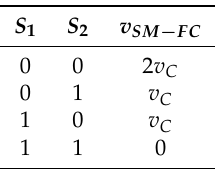
Table 1. Switching states and output voltage of the three-level FC